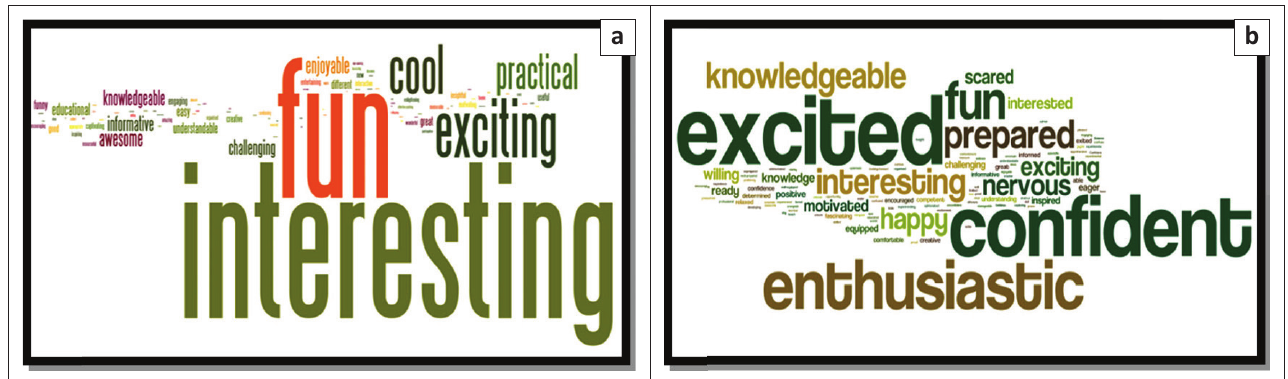
FIGURE 2: The word clouds generated by the (a) 2011 and (b) 2014 cohorts on completion of the module.